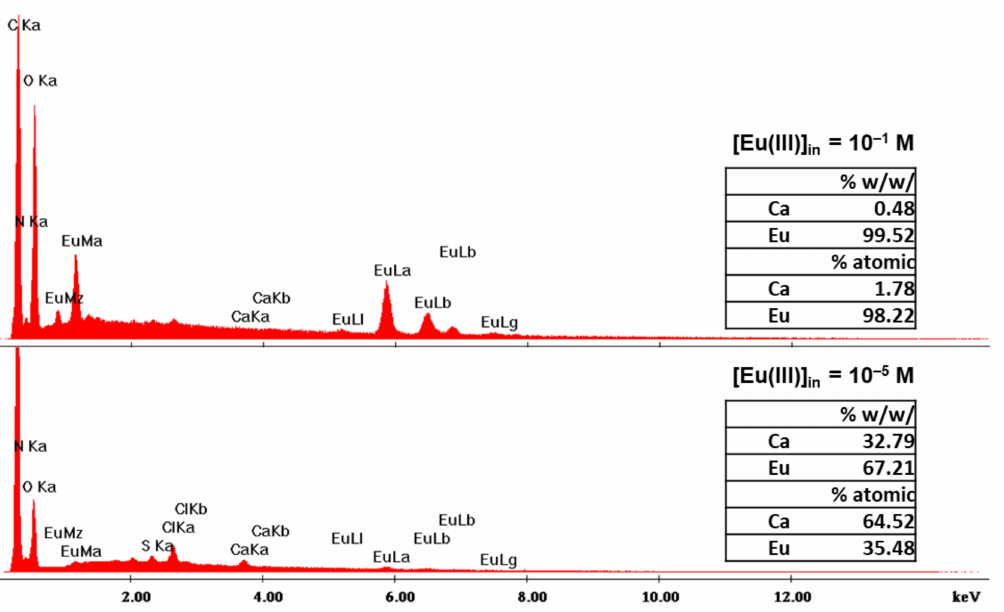
Figure 4. Energy-dispersive X-ray spectra (EDS) of dried X-alginate beads after sorption of different amounts of Eu(III) from solutions with different initial Eu(III) concentrations, as indicated.